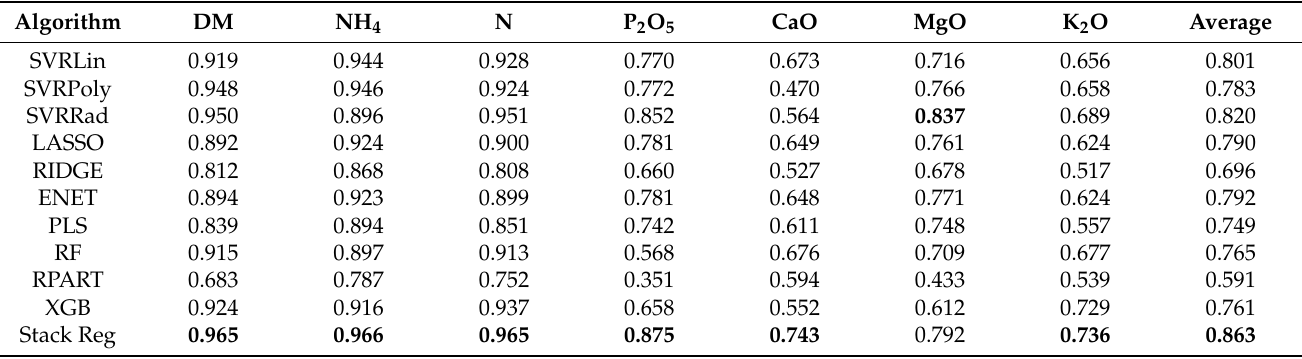
Table 7. Comparison of the R 2 in the testing set among the seven chemical components: dry matter (DM), total ammonium nitrogen (NH 4 ), total nitrogen (N), P 2 O 5 , CaO, MgO, and K 2 O of the fresh homogenized samples using various machine learning techniques (SVRLin = support vector regression with linear kernel; SVRPoly = support vector regression with polynomial kernel; SVRRad = support vector regression with radial kernel; LASSO = least absolute shrinkage and selection operator; RIDGE = ridge regression; ENET = elastic net regression; PLS = partial least squares; RF = random forests; RPART = recursive partitioning and regression trees; XGB = boosted trees). Best results are indicated in